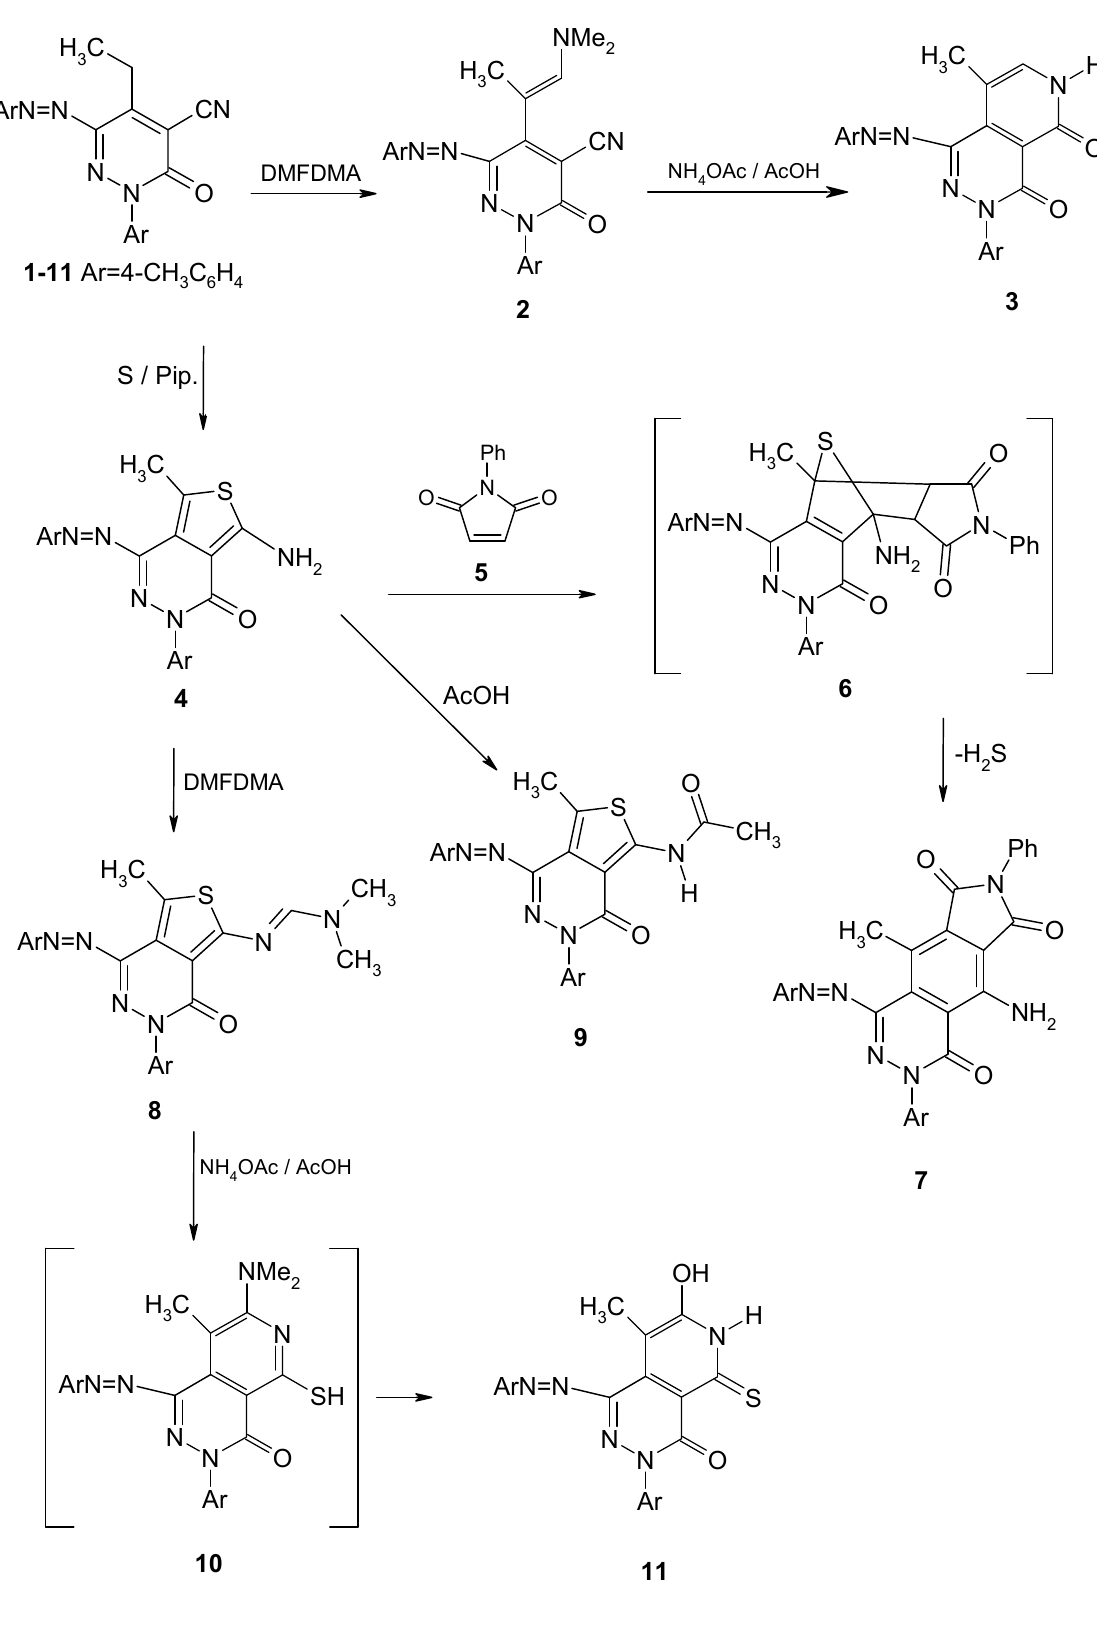
Scheme 1. Preparation of monoazo disperse